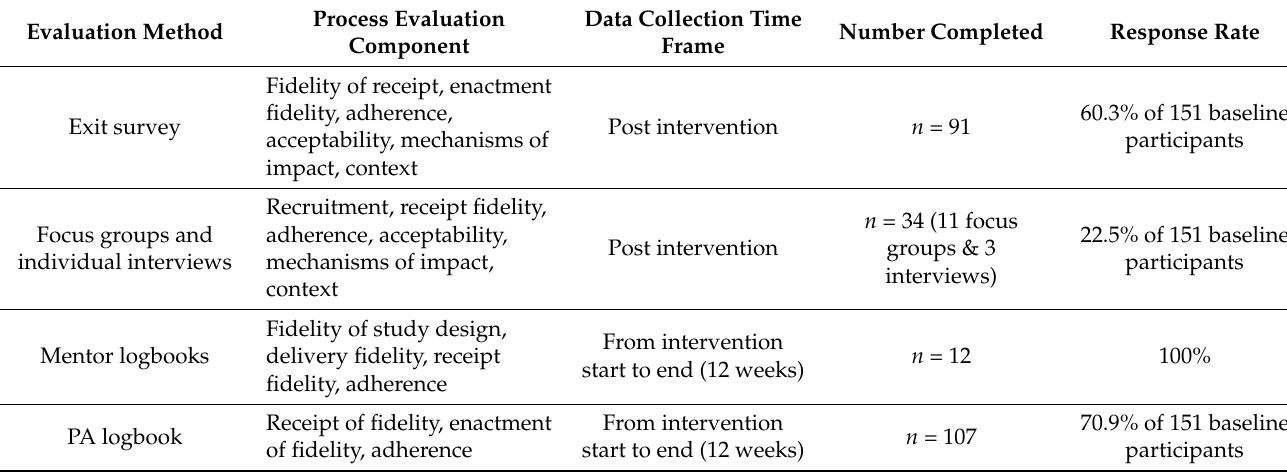
Table 3. Data collected and response